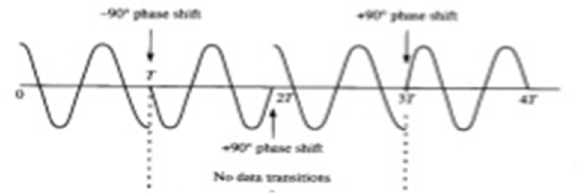
Fig. 6.OQPSK Waveform.